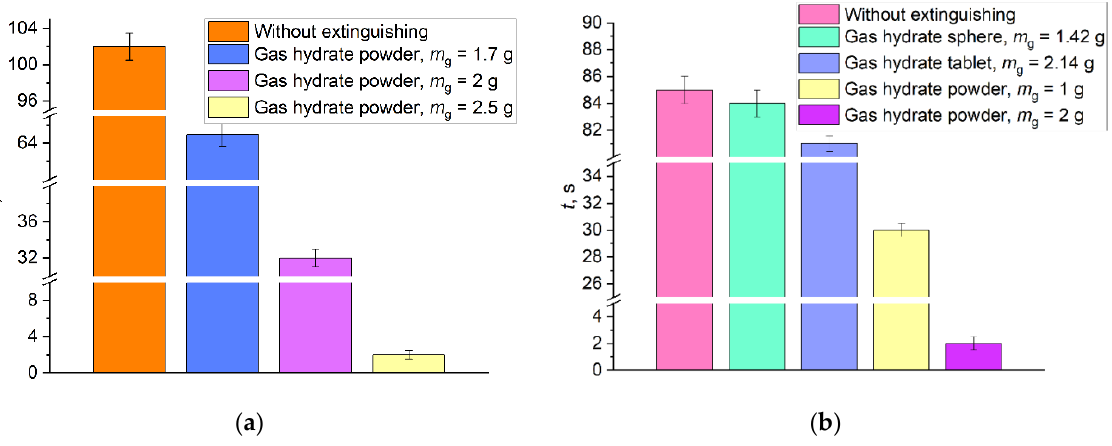
Figure 7. Extinction times of ( a ) kerosene ( V 0 ≈ 3 mL) and ( b ) alcohol ( V 0 ≈ 3 mL) pool fires without extinguishing and when suppressed by CO 2 hydrate in the form of powder, tablets, and spheres with varying initial mass m g .